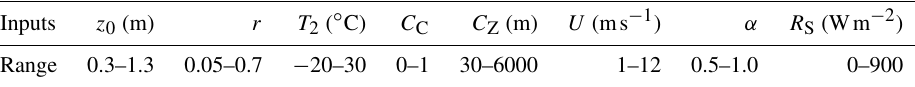
Table 2. Range of parameters used for studying the sensitivity of u ∗ . Six points were linearly spaced within the range, except for U which comprises 10 logarithmically spaced points which amount to roughly 2.8 million combinations of input variables. In the table, z 0 is the roughness length, r is the surface albedo, T 2 is the temperature at the height of 2m, C C is the cloud cover, U is the wind speed at 10m, α is the Priestley–Taylor moisture parameter, and R S is the solar irradiance.